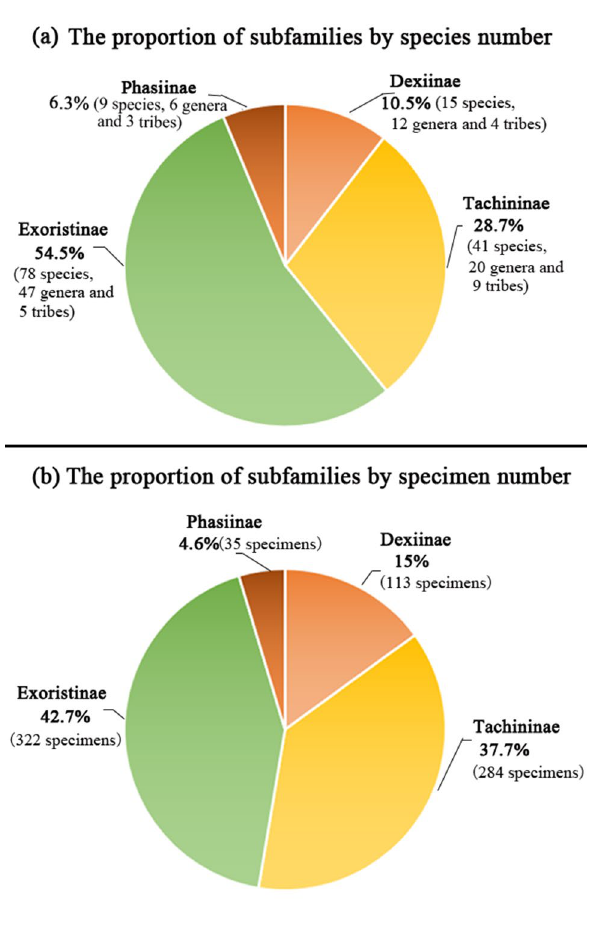
Figure 2. Pie chart of the proportion of each tachinid subfamily by ( a ) the number of species and ( b ) by the number of specimens.